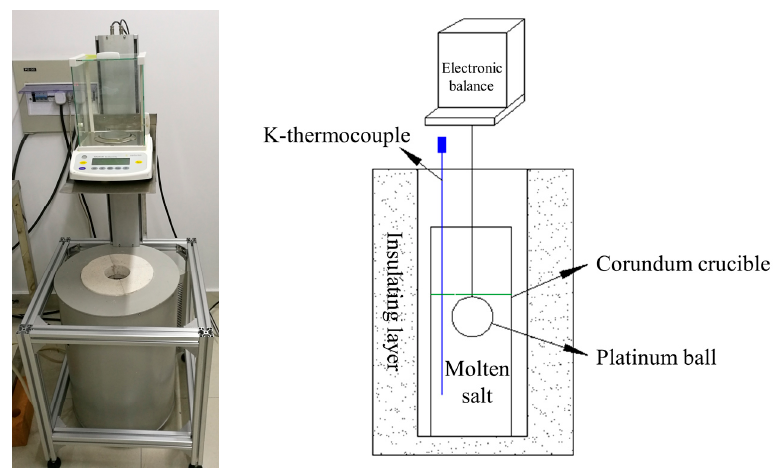
Figure 1. The experimental set-up for density.